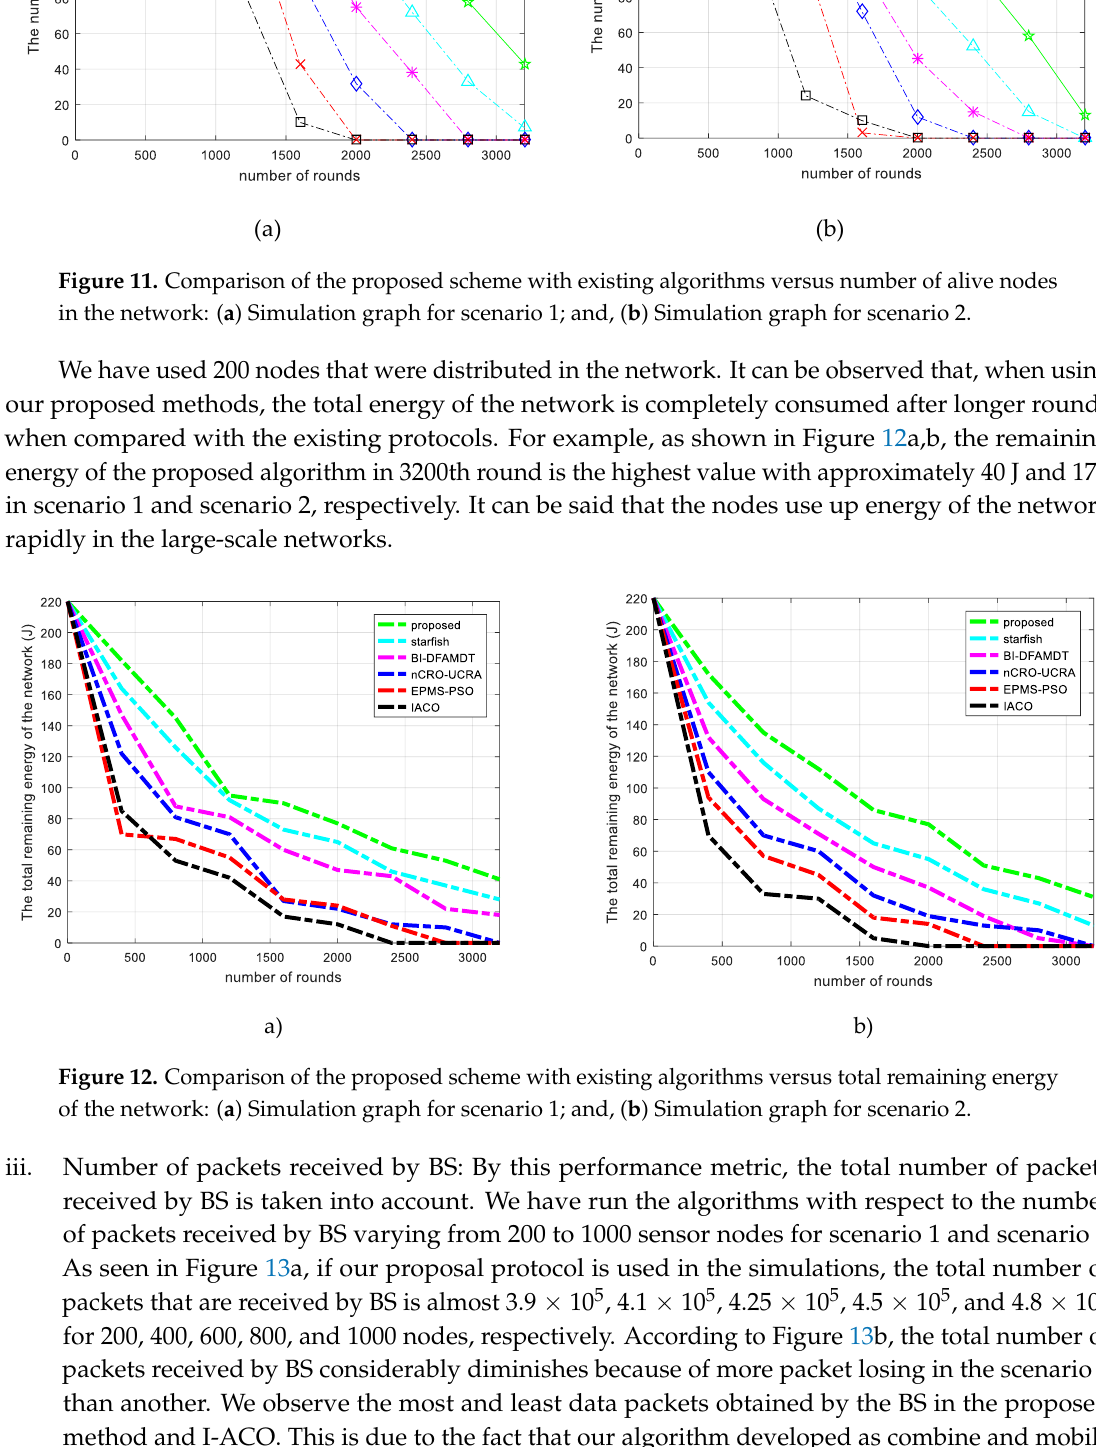
(b) Figure 13. Comparison of the proposed scheme with existing algorithms versus number of packets received by BS: ( a ) Simulation graph for scenario 1; and, ( b ) Simulation graph for scenario 2.